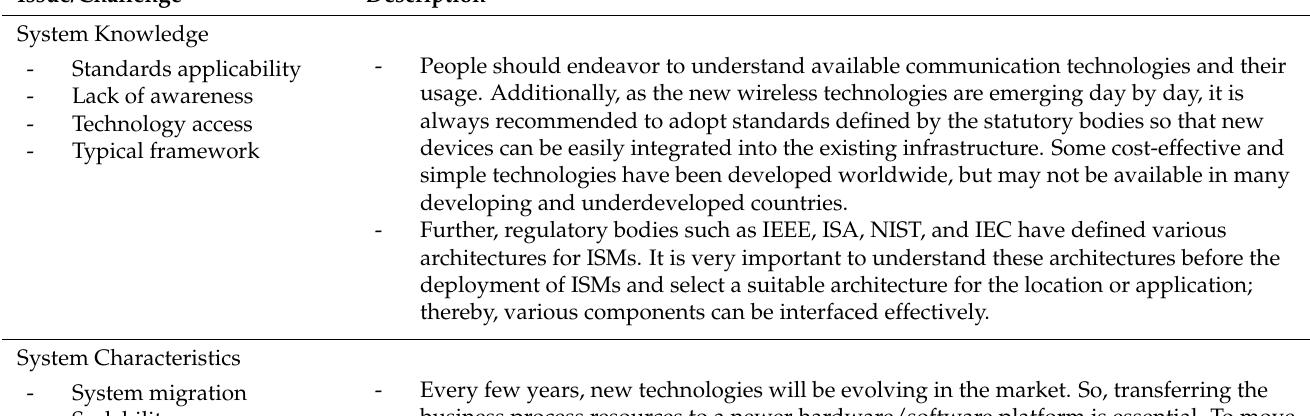
Table 8. Various key issues and challenges for ISM